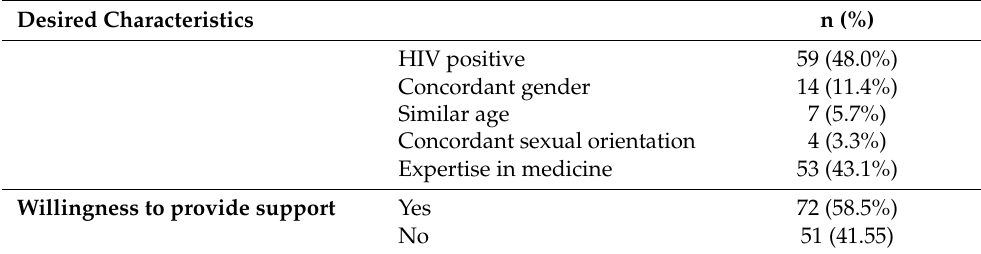
Table 2. Peer Support Preferences of OPWH in Kyiv.